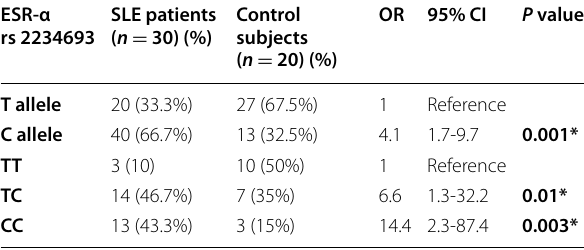
Data are represented as number (%) Data were analyzed using odds ratio ( OR ) and 95% CI : Confidence interval *Significant difference at P 0.05 ≤